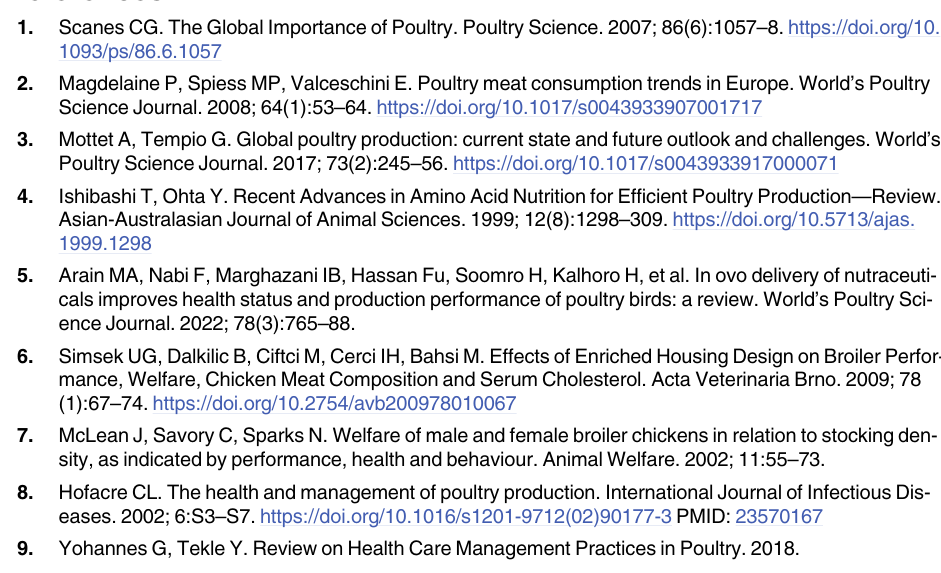
S2 Fig. Re-isolation rates of bacteria found on the eggshell with eggshell rinse method from repetition trial of control and disinfection